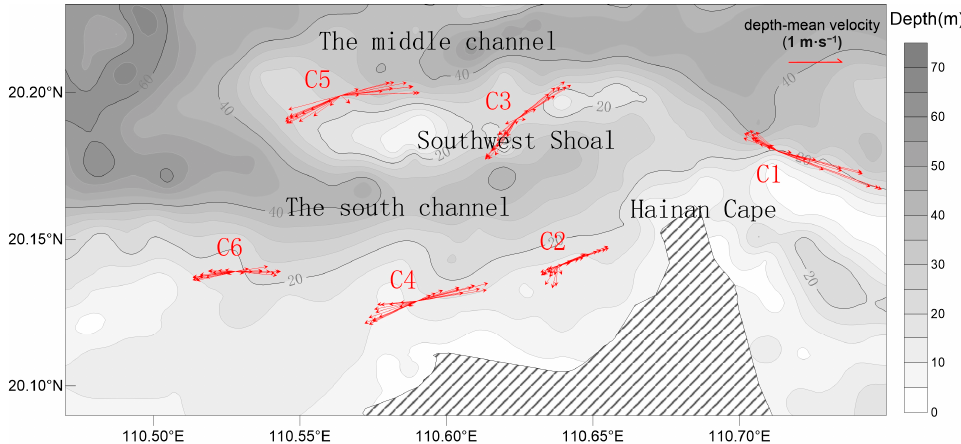
Figure 6. Tidal ellipse of the depth-mean velocity and direction of the tidal current at the six observed stations. The red arrow points in the tidal current direction, while the length of the arrow line indicates the magnitude of the current velocity.